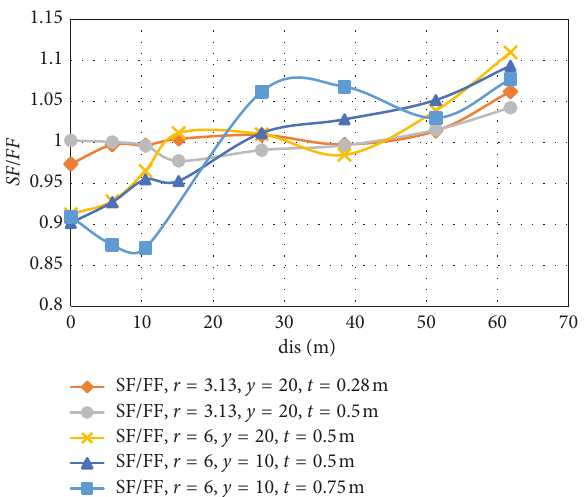
Figure 13: The ratio of SF/FF (for average of spectral accelerations) for models 10–14 of Table 2 at distances of zero, 5.83, 10.50, 15.17, 26.83, 38.5, 51.33, and 61.83 meters from the center of the tunnel projection onto the ground surface and their